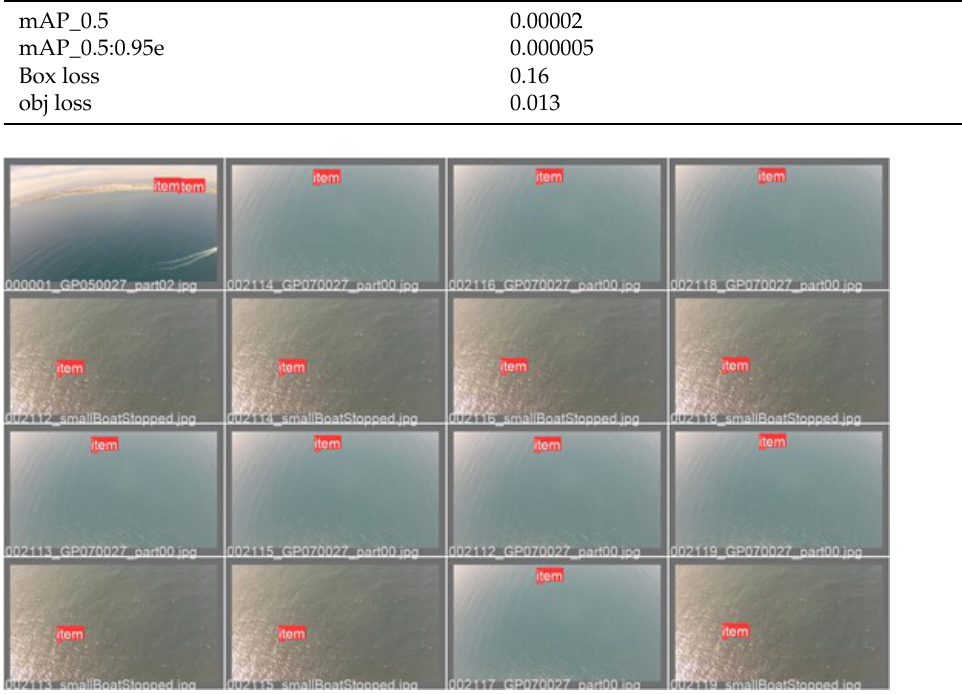
Table 3. Validation on SEAGULL—values of metrics.